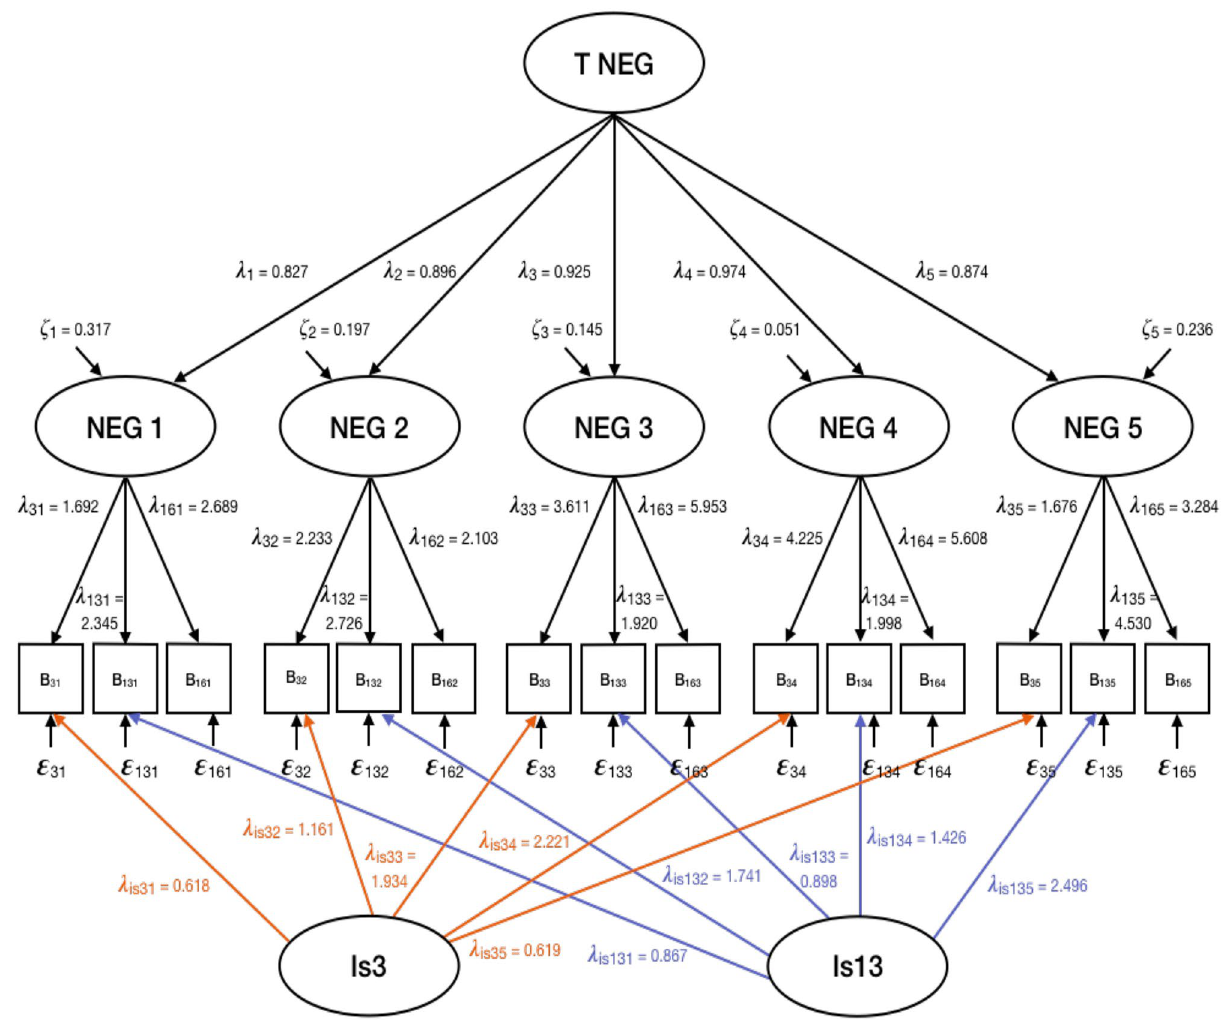
Figure 1. Latent state-trait model for Negative Symptoms (NEG). T common trait factor, λ k factor loading parameters, ζ k latent state residual variables, B ik observed variables with i indicator and k measurement occasion, ε ik error variables, Is indicator-specific trait